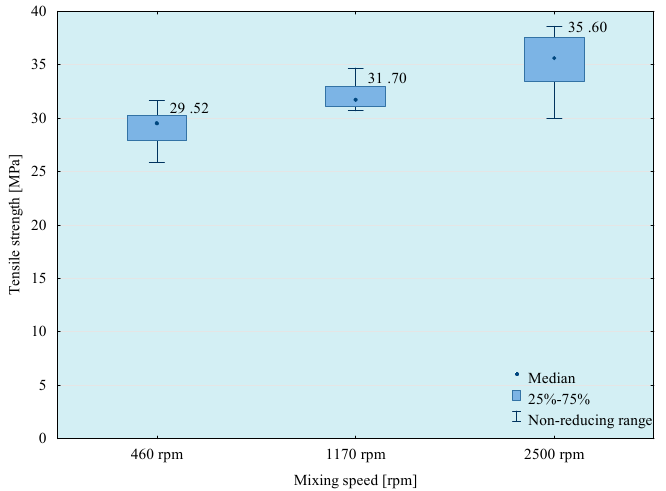
Figure 8. Tensile strength of E57/Z-1/ZR2/100:10:5 composition as a function of mixing speed.